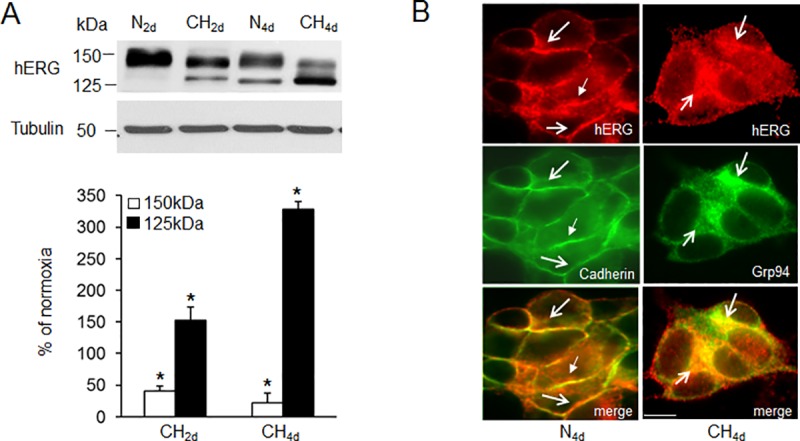
Effect of continuous hypoxia (CH) on hERG protein expression.A). Representative immunoblot of hERG protein in SH-SY5Y cells exposed to either normoxia (N) or 2 or 4 days of CH (1.5% O2) (Top panel). Densitometric analysis (mean ± SEM) of hERG protein normalized to tubulin and expressed as percentage of normoxia (Bottom panel). n = 5 individual experiments. * denotes p <0.01 B) Immunolocalisation of hERG (red) with cadherin (green) and Grp94 (green) in cells exposed to normoxia (N) and CH4d respectively. Arrows denote membrane localization and ER accumulation of hERG in N and CH cells respectively.